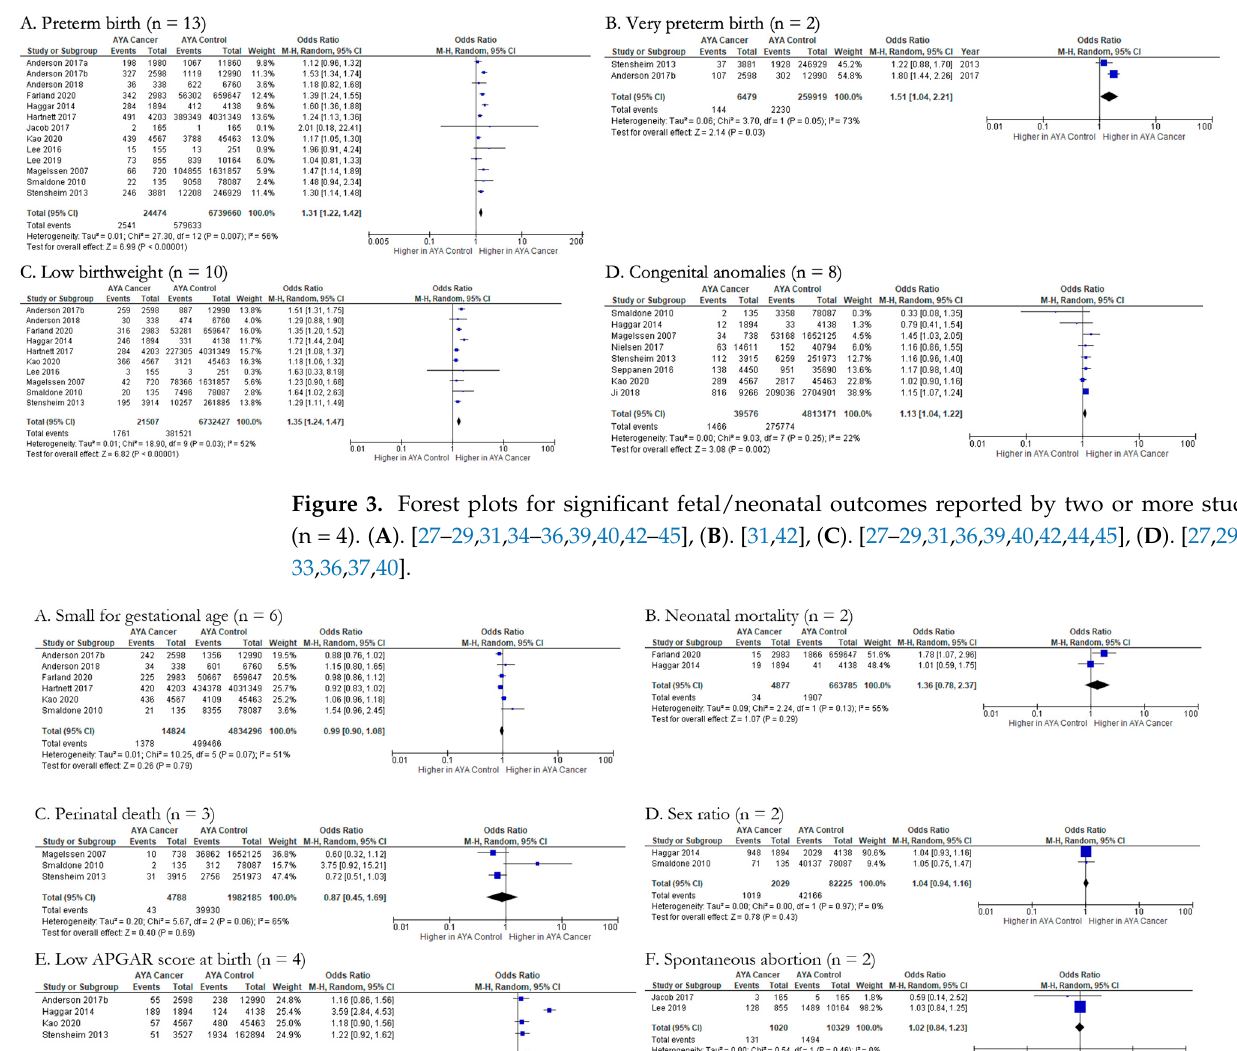
Figure 4. Forest plots for non-significant fetal/neonatal outcomes reported by two or more studies (n = 6). A. [27,39,40,42,44,45], B. [36,44], C. [29,31,40], D. [36,40], E. [27,31,36,42], F. [34,35].